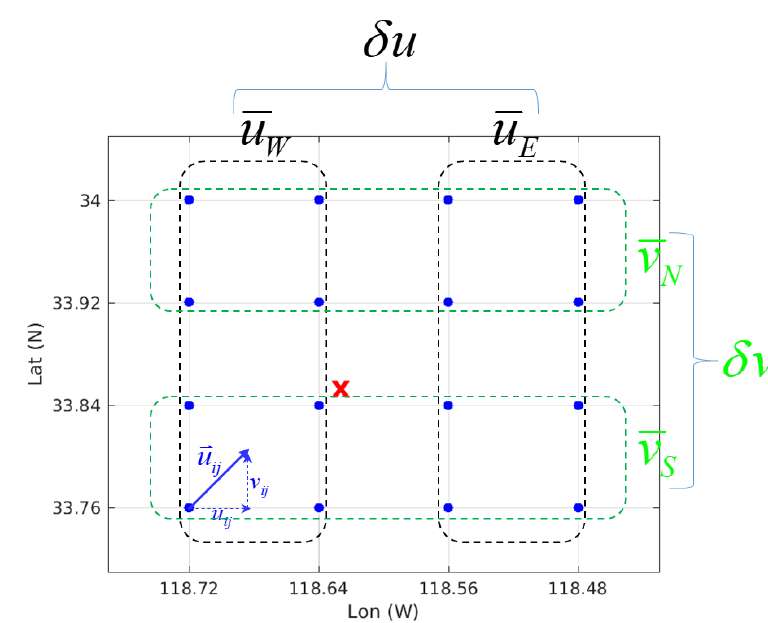
Figure 2. Determination of surface current shear, example for buoy 028 (located at red X). Velocity components u E , u W , v N , v S are averaged from groups of 8 points to E, W, N, and S of buoy location, and then shear along each Cartesian axis ( δ u , δ v ) is determined from these averaged velocities. Near surface (10 m) wind fields were obtained from the NCEP Climate Forecast System Reanalysis for the periods 1996–2010 (CFSRv1, ds093.1) and 2011–2019 (CFSRv2, ds094.1) at hourly intervals and 0.5 ° resolution [31,32]. The CFSR is a global coupled atmosphere–land–ocean–ice system with 64 atmospheric layers and 40 ocean layers. The reanalyses assimilate wind observations from satellite imagery, scatterometer, microwave imager data of the ocean surface, and numerous other sources. CFSR wind datasets are used in the generation of GOFS3.1 ocean surface currents and thus are the most appropriate choice for the present analysis.